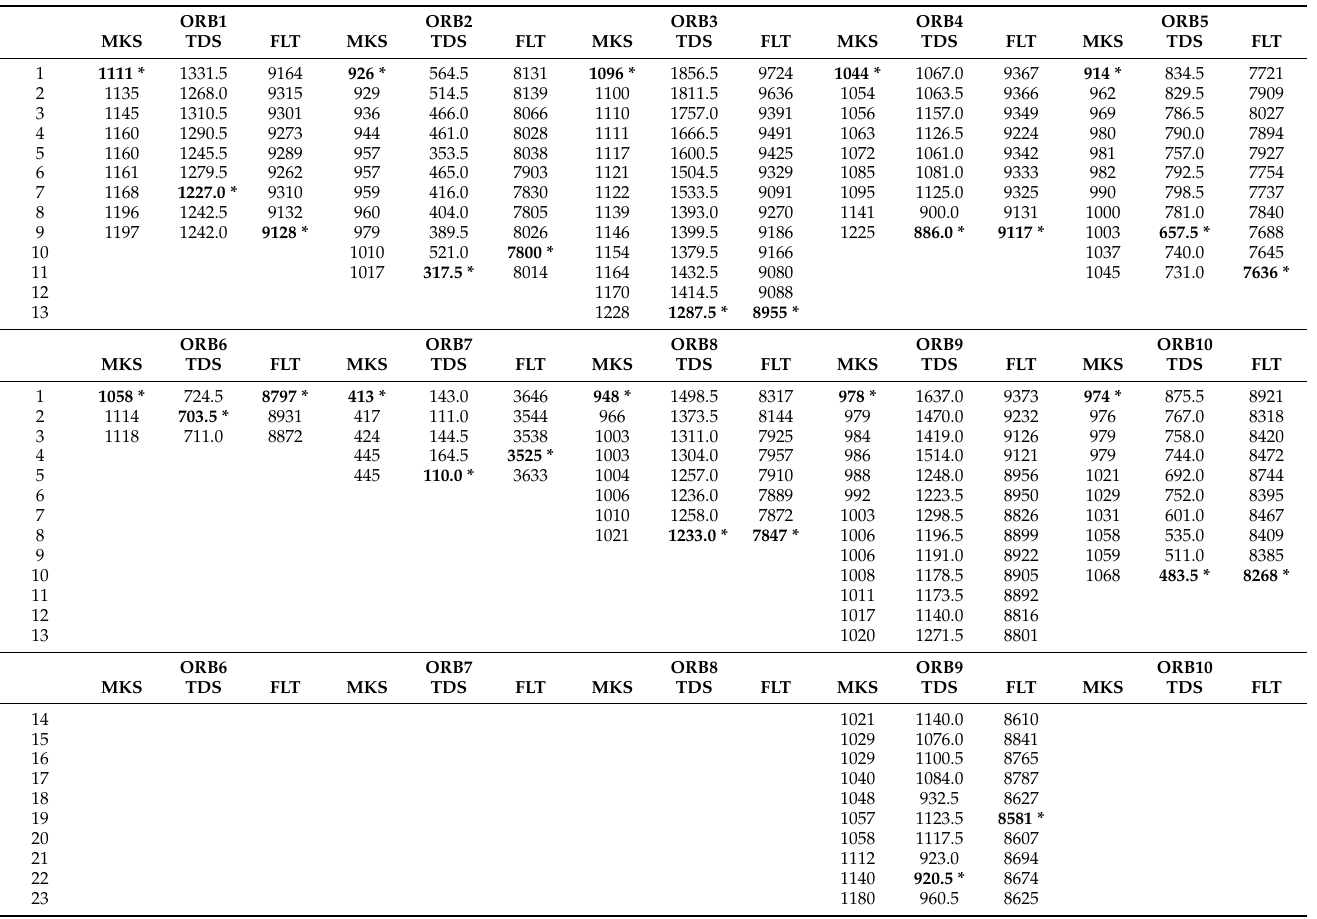
Table A14. Non-dominated solutions obtained by SS/CMOTA for the JSSP instances proposed by [37].